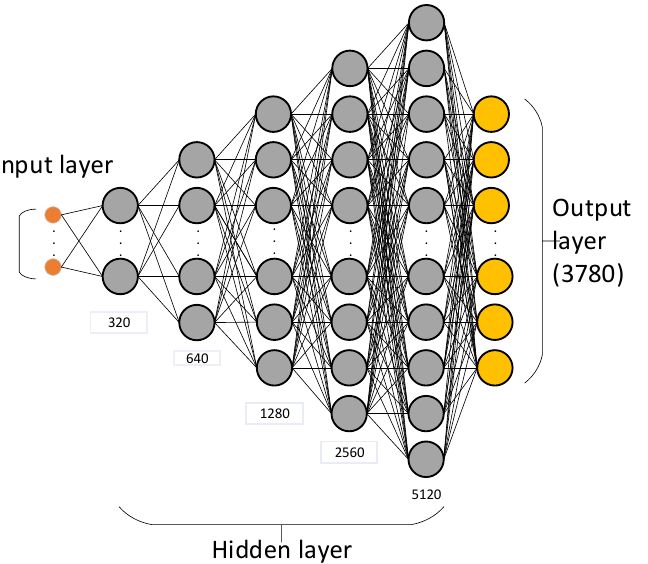
Figure 4. The design using a fully connected neural network diagram.